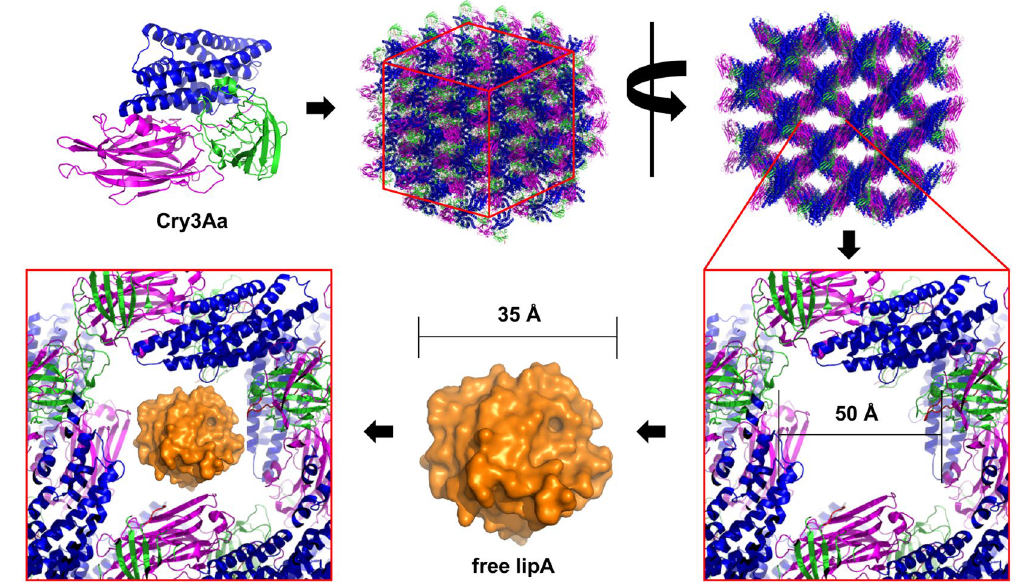
Figure 1. Schematic illustrating the design strategy used for optimization of Cry3Aa-lipA activity. Cry3Aa monomers form a tightly ordered crystal with ~50 Å by 50 Å channels 30 that could easily accommodate free lipA 27 (~35